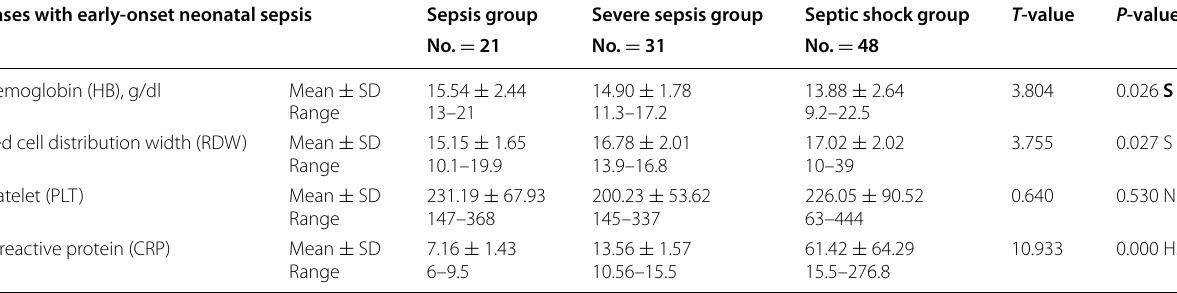
S significant, NS not significant, HS highly significant Table 4 Comparison between cases with low HB levels and cases with normal HB levels regarding RDW Cases with early-onset neonatal sepsis